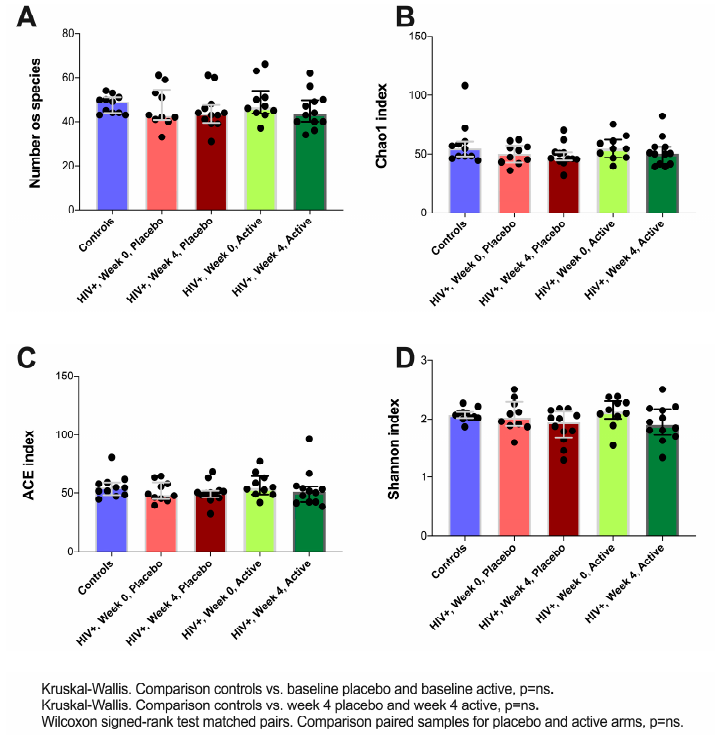
Figure 1. Alpha diversity metrics comparison across study groups. ( A ), Number of species, illustrates de number of unique taxa identified. ( B ), Chao1, an estimation of real richness based on the number of taxa supported by either 1 or 2 sequencing reads. ( C ), ACE, an estimation of real richness based on the number of taxa supported by 10 reads. ( D ), Shannon, a metric to quantify the uncertainty of the taxonomic identity of an unknown entity in a community based on the number of different entities and their abundance.